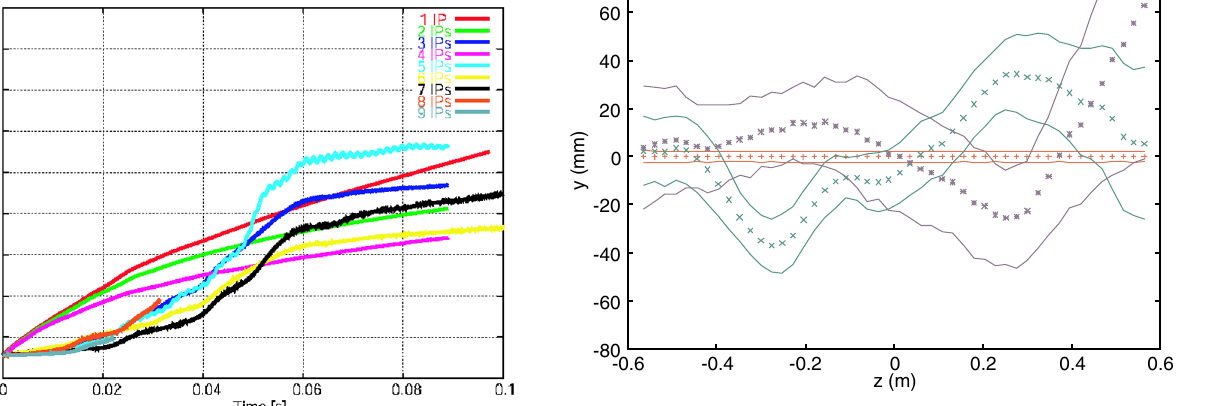
FIG. 49. (Color) Vertical emittance growth in the LHC at injec- tion as a function of time, simulated by HEADTAIL , for various numbers of beam-electron interaction points (the various curves), increasing from 1 to 9 in steps of 1; the cloud density is 6 (cid:1) 10 11 m (cid:2) 3 [29].